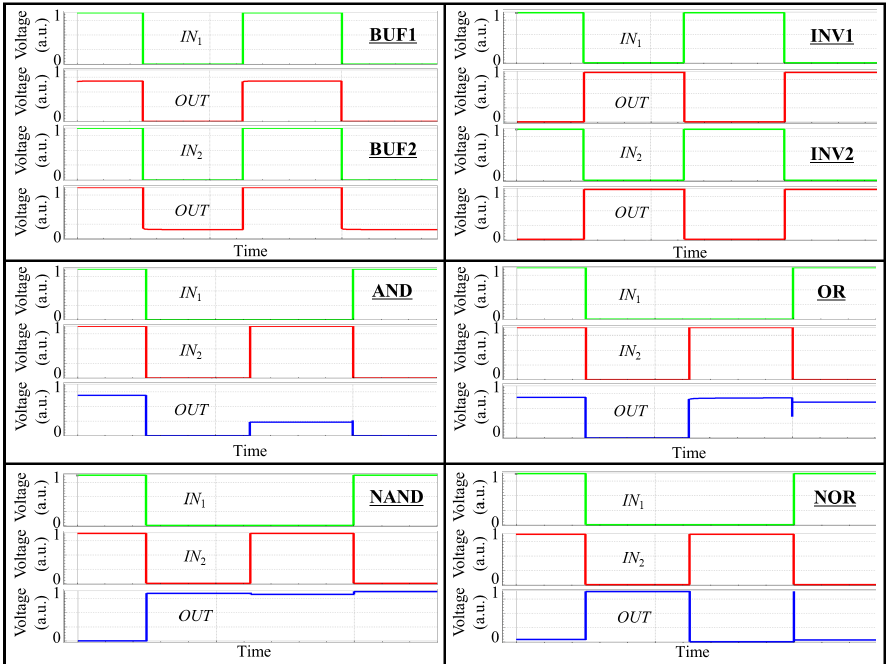
Figure 12. SPICE simulation